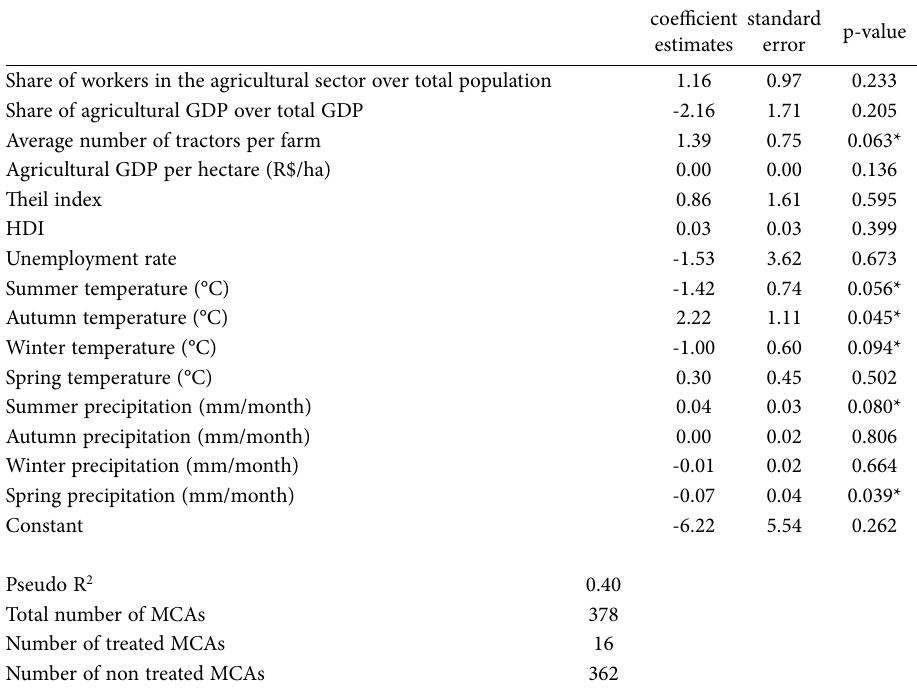
Table 3. Coefficient estimates of the probit model on the probability of growing